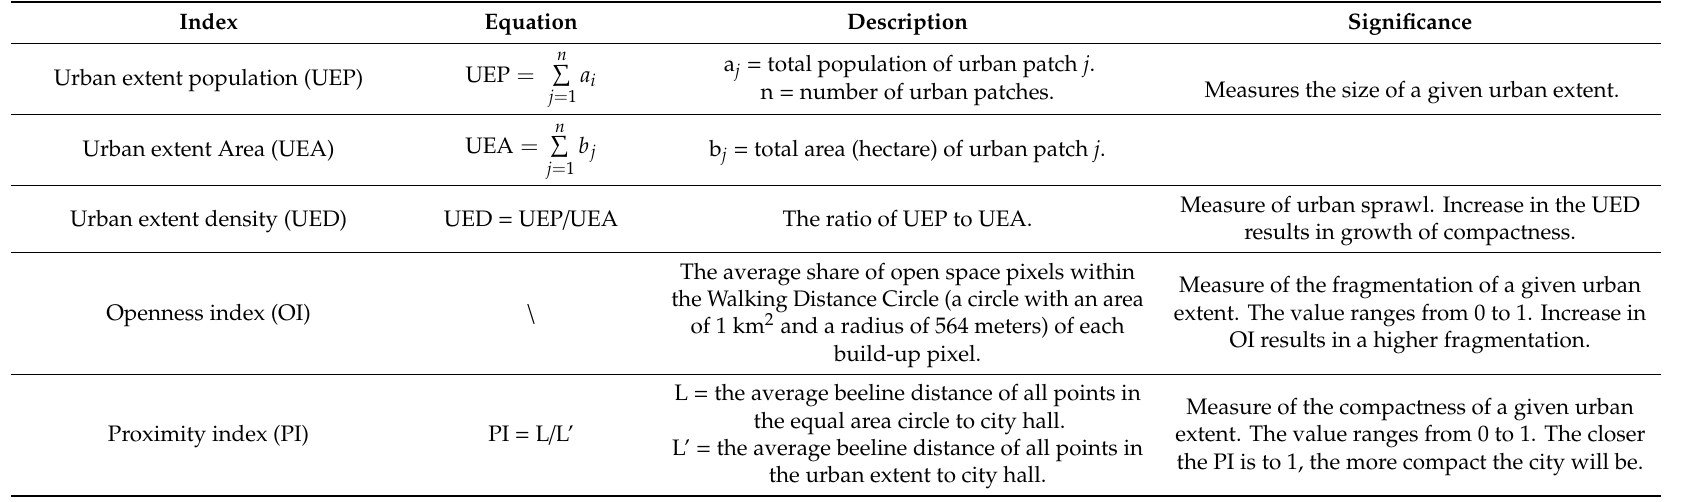
Table A1. Descriptions of urban form metrics used in this